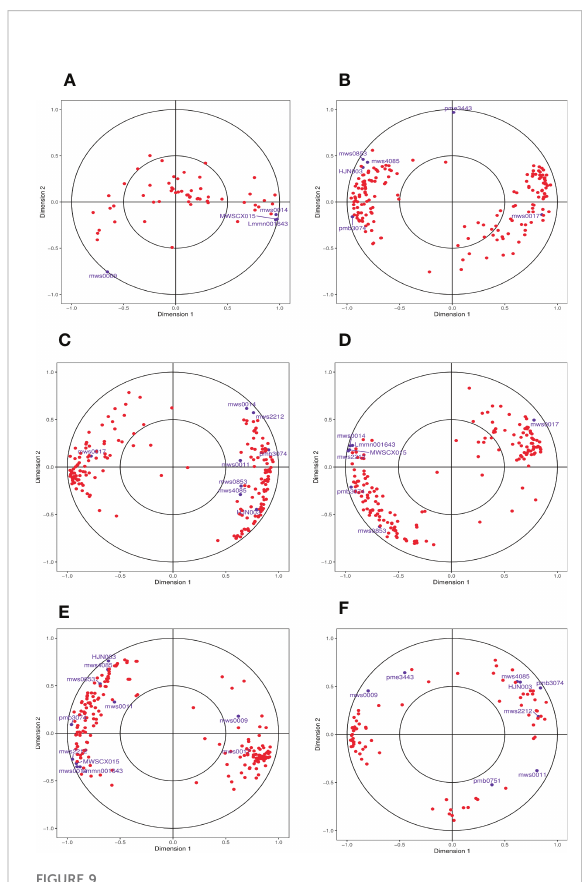
FIGURE 9 Graph of CCA of DEGs and DAMs in the phenylpropanoid biosynthesis pathway. (A) The comparison group of 0 h vs. 1 h. (B) The comparison group of 0 h vs. 12 h. (C) The comparison group of 0 h vs. 24 h. (D) The comparison group of 1 h vs. 12 h. (E) The comparison group of 1 h vs. 24 h. (F) The comparison group of 12 h vs. 24 h. Four regions are distinguished by crosses in the fi gure, and the longer the distance from the origin and the nearer to each other within the same region, the higher the correlation. Metabolites are labeled in purple and genes are labeled in red. If there are too many substances in a certain category, they are shown with dots instead to avoid text